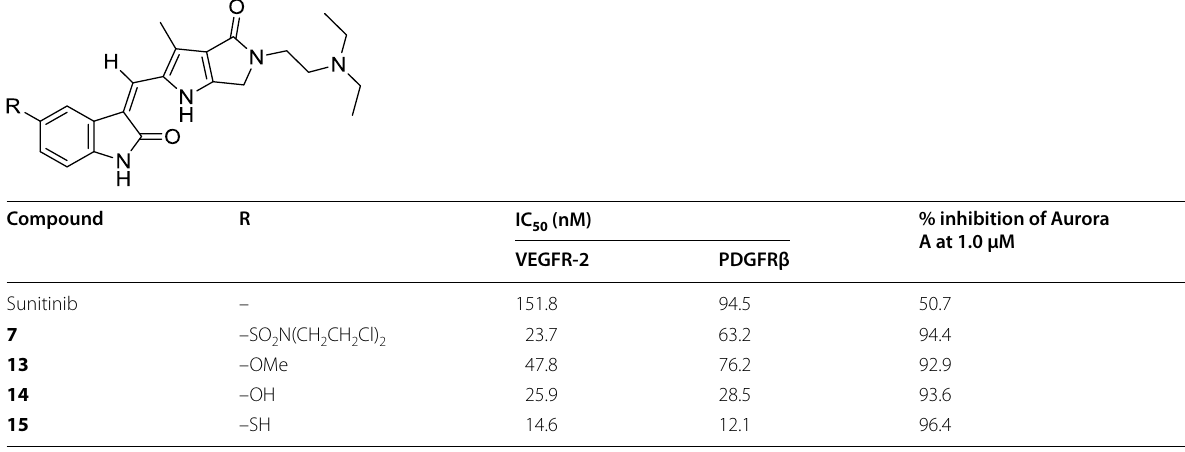
Table 2 In-vitro kinase inhibitory activities of 7, 13–15, and sunitinib